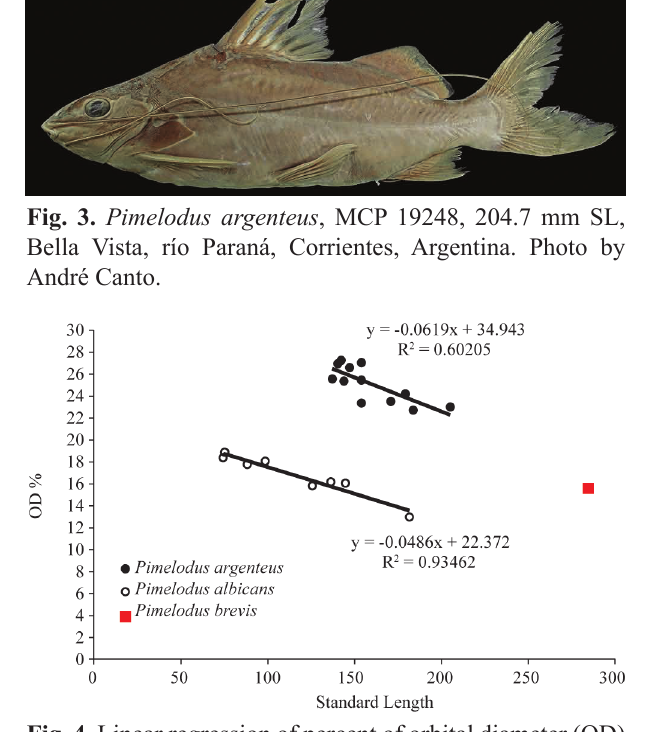
Fig. 4. Linear regression of percent of orbital diameter (OD) on standard length of Pimelodus argenteus , P. albicans , and P. brevis . R 2 = coefficient of determination.